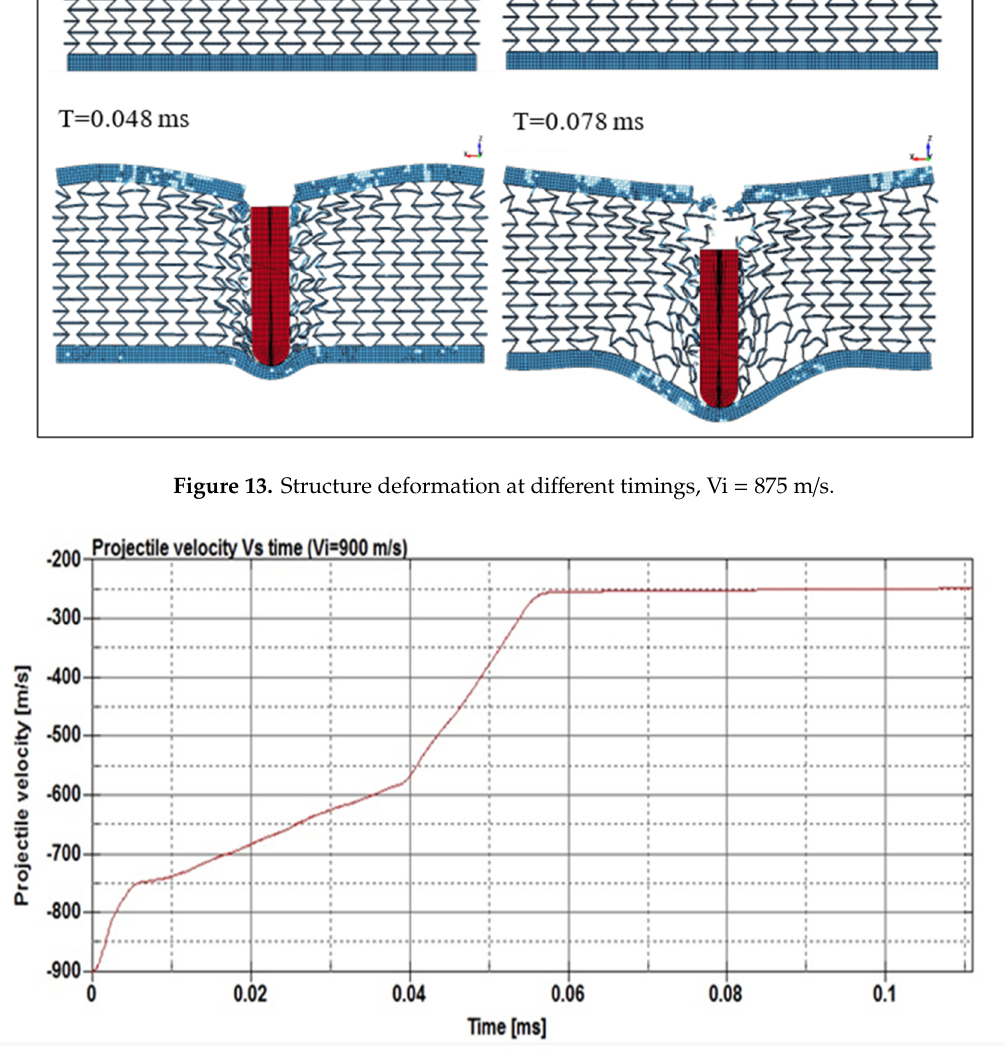
Figure 14. Projectile velocity vs. time for the NiTi auxetic structure at a projectile speed of 900 mm/s.